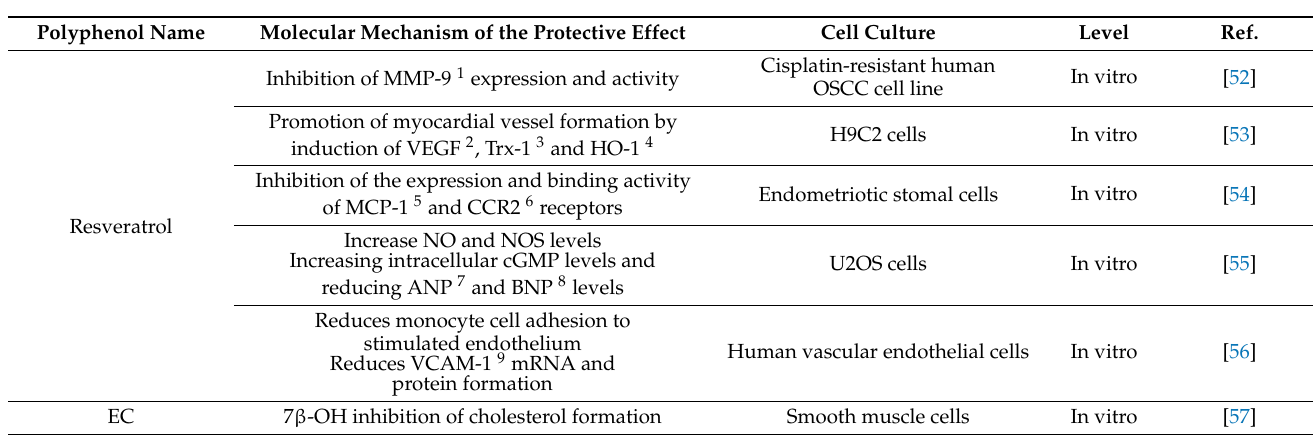
Table 6. Anti-atherosclerotic and cardioprotective effects of polyphenols isolated from grape marc (grape seeds and grape